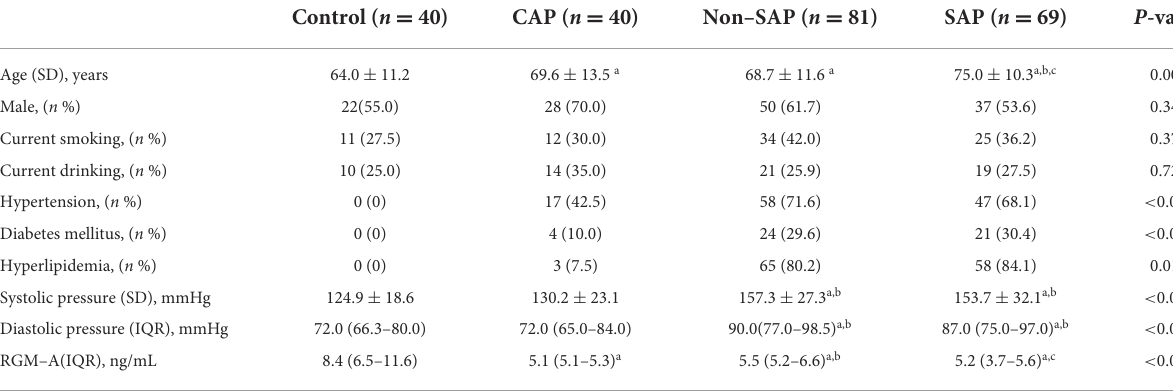
TABLE 2 Baseline characteristics and RGM–A levels among the four groups.